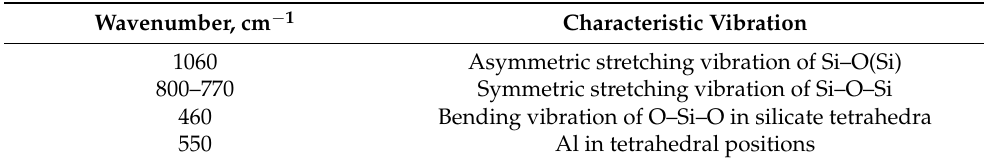
Figure 6. IR spectra of PUR foam, M, and PUR foam modified with 20 wt.% of M (PUR + M20p). Table 4. Absorption bands of the FA and M structure [46,47].